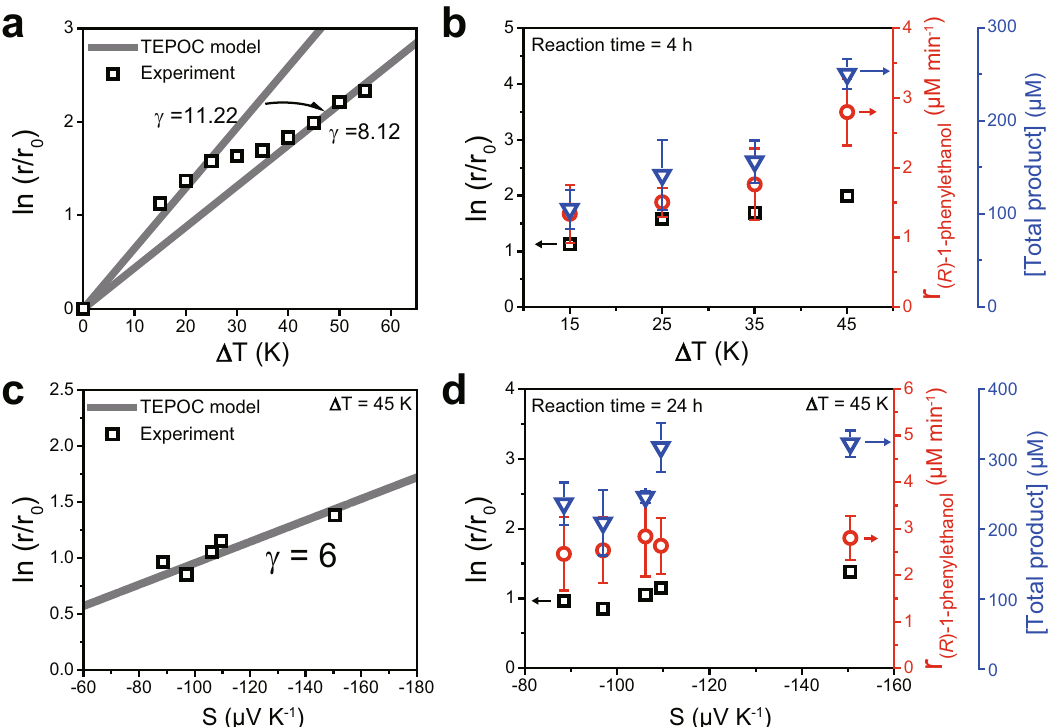
Fig. 5 Effect of thermoelectric parameters on catalytic activity of thermoelectrocatalytic H 2 O 2 generation and thermoelectrobiocatalytic ethylbenzene hydroxylation. The dependencies of H 2 O 2 production rate, ( R )-1-phenylethanol production rate, and product yield of thermoelectrobiocatalytic ethylbenzene conversion on ( a , b ) applied Δ T from 0 to 55K and ( c , d ) Seebeck coef fi cient ( S ) of the Bi 2 Te 3 , respectively. Reaction conditions: 5mgmL − 1 Bi 2 Te 3 dispersed in an O 2 -purged KPB (100mM, pH 7.0) with applied Δ T . For biocatalytic reactions, 50nM r Aae UPO and 100mM ethylbenzene were also dispersed in an O 2 -purged KPB (100mM, pH 7.0). H 2 O 2 production rates were determined at 60min of reaction for ( a , b ) and 15min of reaction for ( c , d ). Ethylbenzene conversion rates were determined at 60min of reaction. Product yield was determined at 4h of reaction for ( b ) and 24h of reaction for ( d